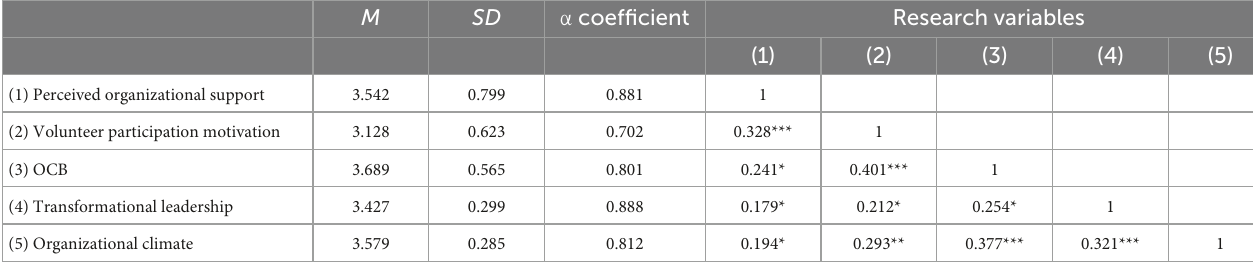
TABLE 1 Descriptive statistics, correlation coefficient, and alpha